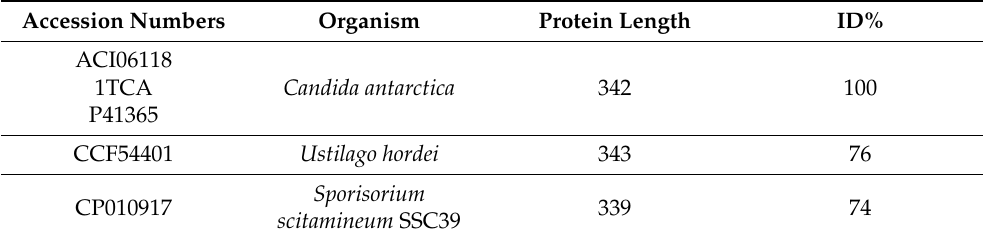
Table 1. Representative lipase sequences that were identified. The Candida antarctica lipase CaLB was included in the table for comparison. The identity percentage (ID%) is in referenced to the CaLB sequence.